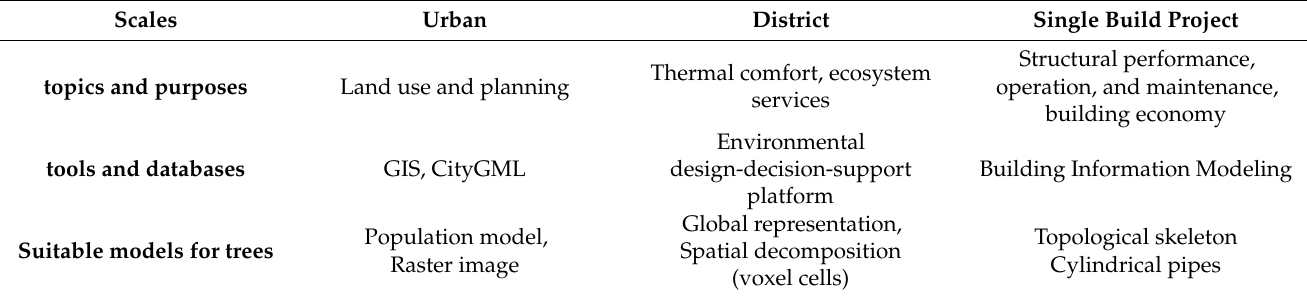
Table 1. Comparison of digital tools and tree representations in different scales. Scales Urban District Single Build Project Structural performance, Thermal comfort, ecosystem topics and purposes Land use and planning operation, and maintenance, services building economy Environmental tools and databases GIS, CityGML design-decision-support Building Information Modeling platform Global representation, Population model, Topological skeleton Suitable models for trees Spatial decomposition Raster image Cylindrical (voxel cells)